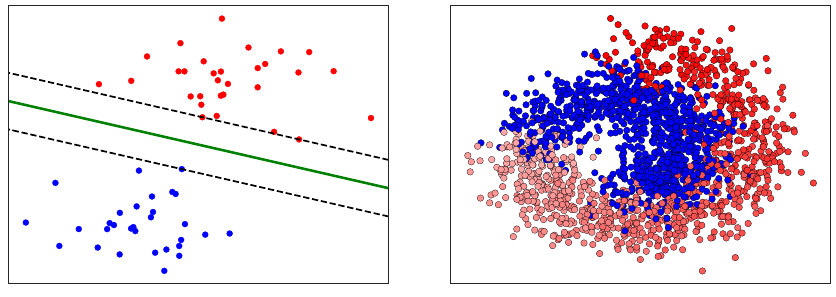
Figure A3. A linearly-separable dataset ( left ), versus a non-linearly-separable dataset ( right ), adapted from [51].